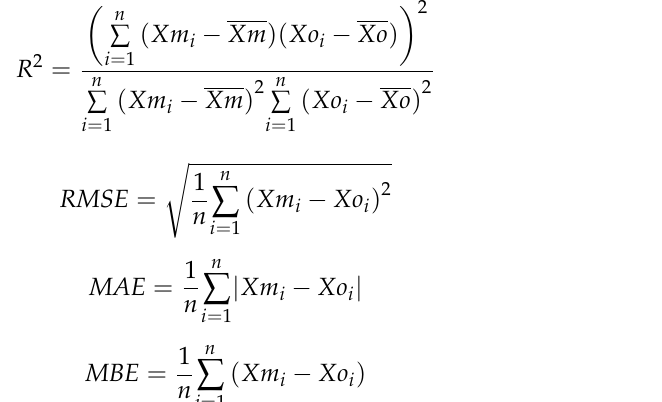
Table 5. The selection and used range of hyper-parameters of the various machine learning models. Model The Selection and Used Range of Hyper-Parameters The maximum tree depth varied between 1 to 10 at 1 interval and the CART number of trees was 1 The maximum tree depth varied between 1 to 10 at 1 interval and the ET number of trees ranged from 10 to 100 at 10 intervals The number of trees ranged from 250 to 500 at 50 intervals and the RF maximum depth of tree ranged from 2 to 12 at 2 intervals The minimum leaf size varied between 2 to 12 at 2 intervals, and the GBDT number of rounds ranged from 1000 to 8000 at 1000 intervals The eta was 0.01, the minimum leaf size varied from 2 to 10 at 2 XGBoost intervals and the number of rounds ranged from 200 to 2000 at 200 intervals The maximum tree depth varied between 2 to 12 at 2 intervals, and LightGBM the number of trees varied between 100 to 600 at 100 intervals The subset ratio of all datasets ranged from 0.5 to 1 at 0.05 intervals, the maximum tree depth CatBoost varied between 2 and 10 at 2 intervals and the number of rounds varied from 200 to 800 at 100 intervals MLP The number of hidden neutrons ranged from 1 to 10 at 1 intervals The penalty parameter cost ranged from 10 to 100 at 10 intervals, and SVM the parameter gamma ranged from 10 to 120 at 10